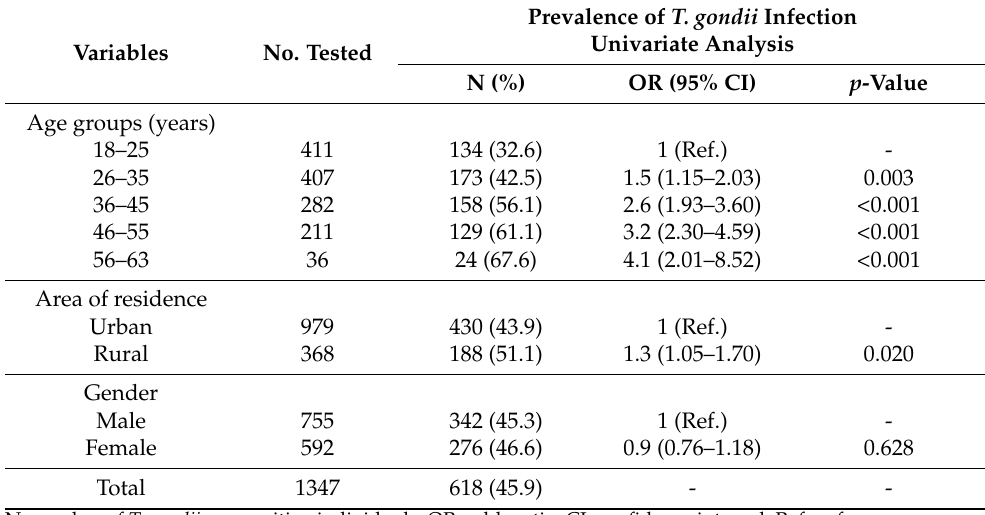
Table 1. Seroprevalence of Toxoplasma gondii infection in blood donors from Western Romania according to age, area of residence and